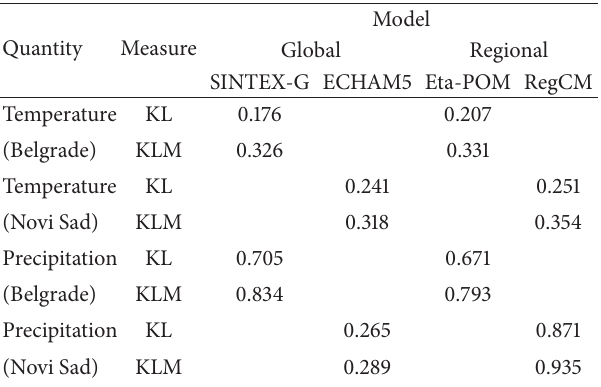
Table 1: Kolmogorov complexity (KL and its maximum: KLM) values for the precipitation and air temperature time series for Belgrade and Novi Sad, in Serbia, obtained from climate simulations using different